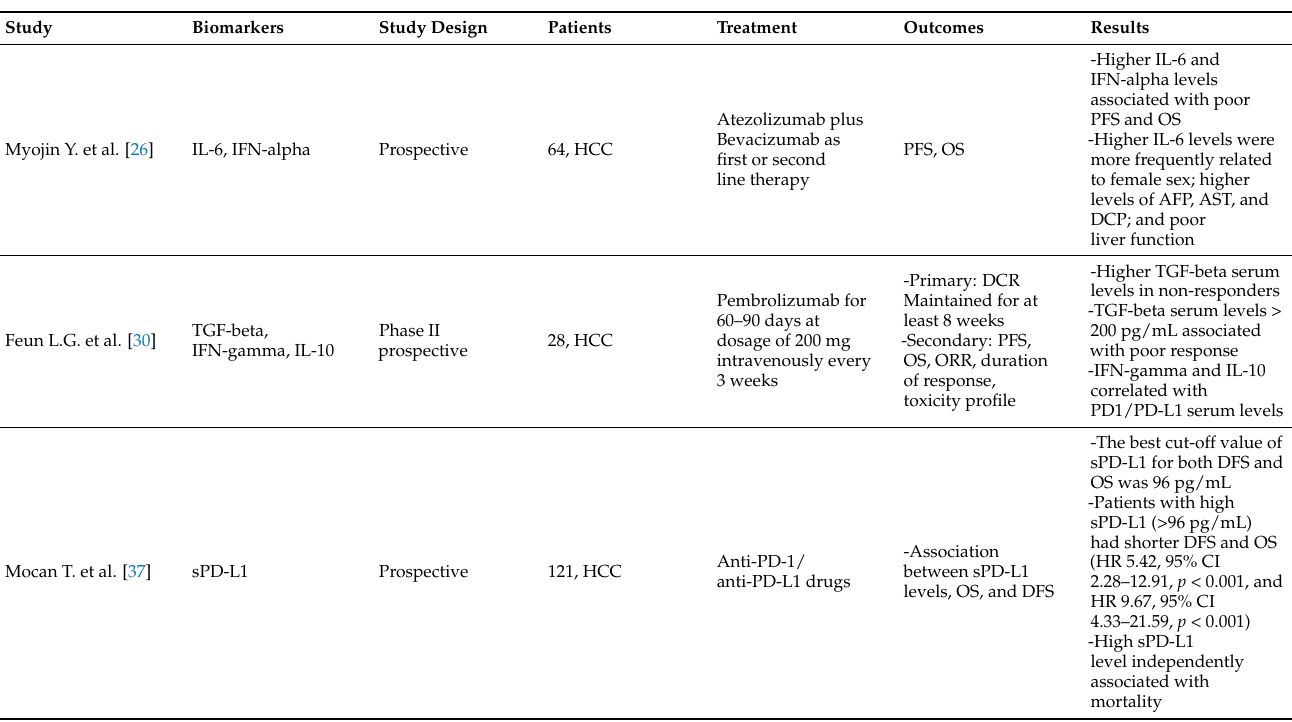
Table 1. Traditional non-invasive biomarkers for immunotherapy in patients with hepatocellular carcinoma